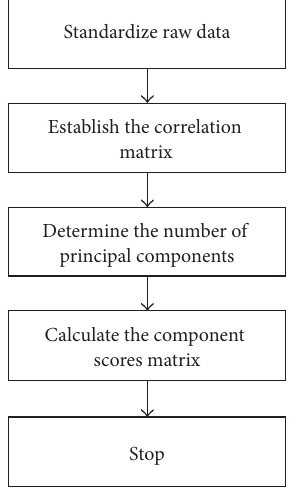
Figure 2: The PCA